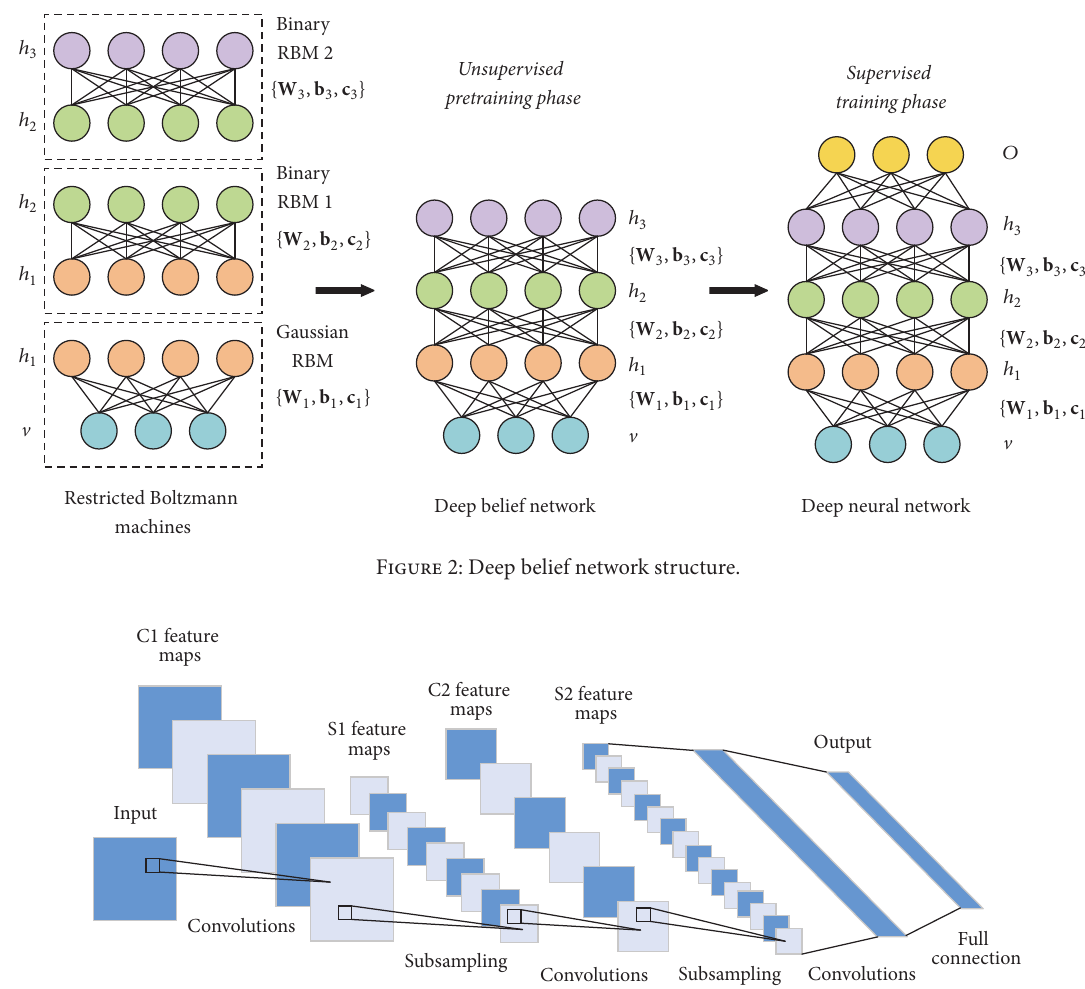
Figure 3: The architecture of convolution neural